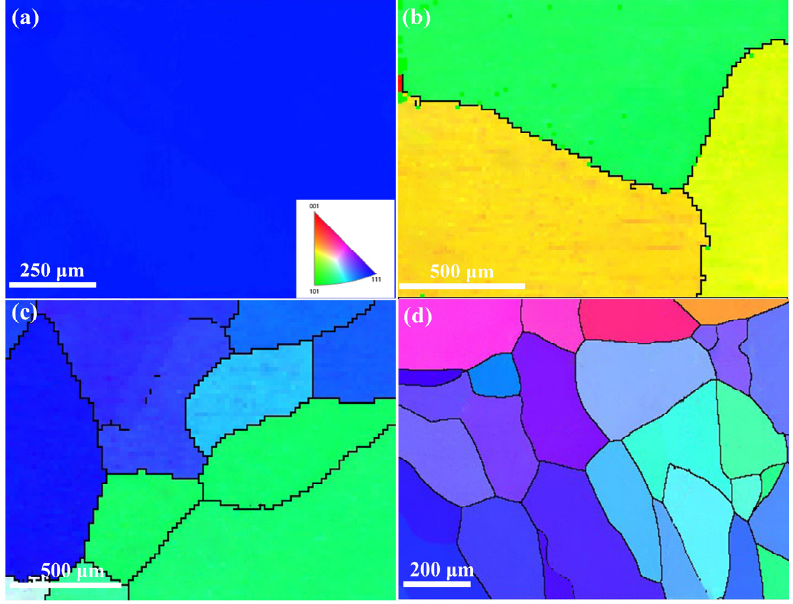
Figure 7. EBSD characterization of the as-cast Cu-0.5Sn alloys: inverse pole figure maps and corresponding grain size distributions of ( a ) G = 1, ( b ) G = 100, ( c ) G = 500, and ( d ) G = 1000.